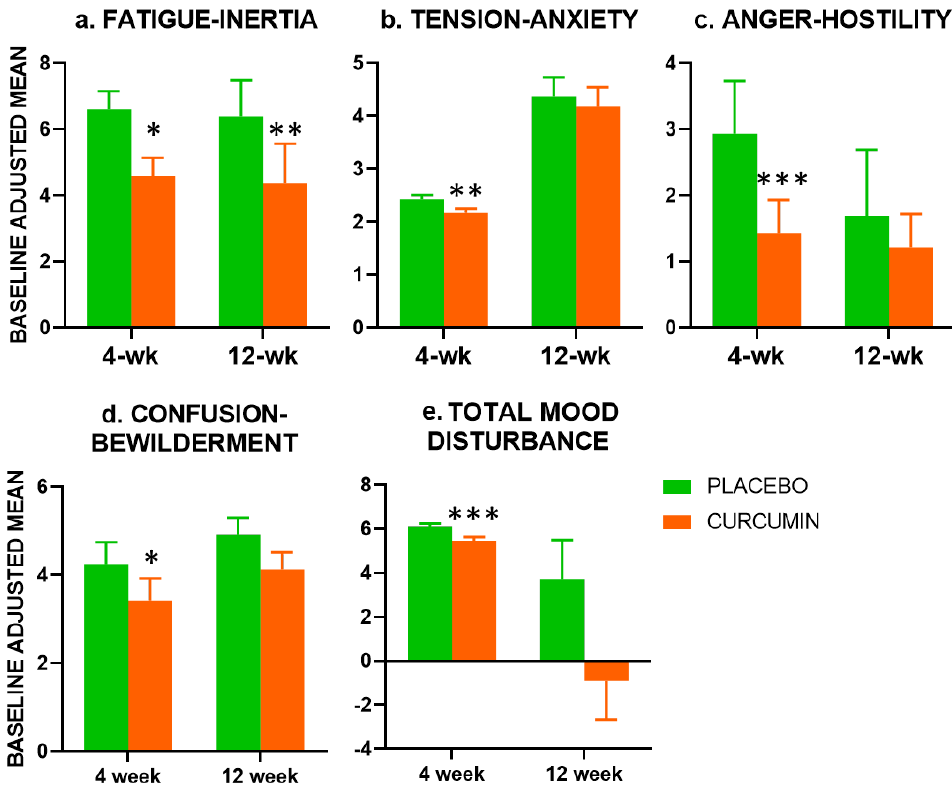
Figure 2. Effects of Longvida © curcumin on mood. Graphs depict baseline adjusted means with SEM (or 95% confidence intervals due to back transformation for a. 12-wk, c. both, d. 4-wk; see Supplementary Table S3 for unadjusted means and standard deviations). *, p < 0.05; **, p < 0.01; ***, p < 0.005.